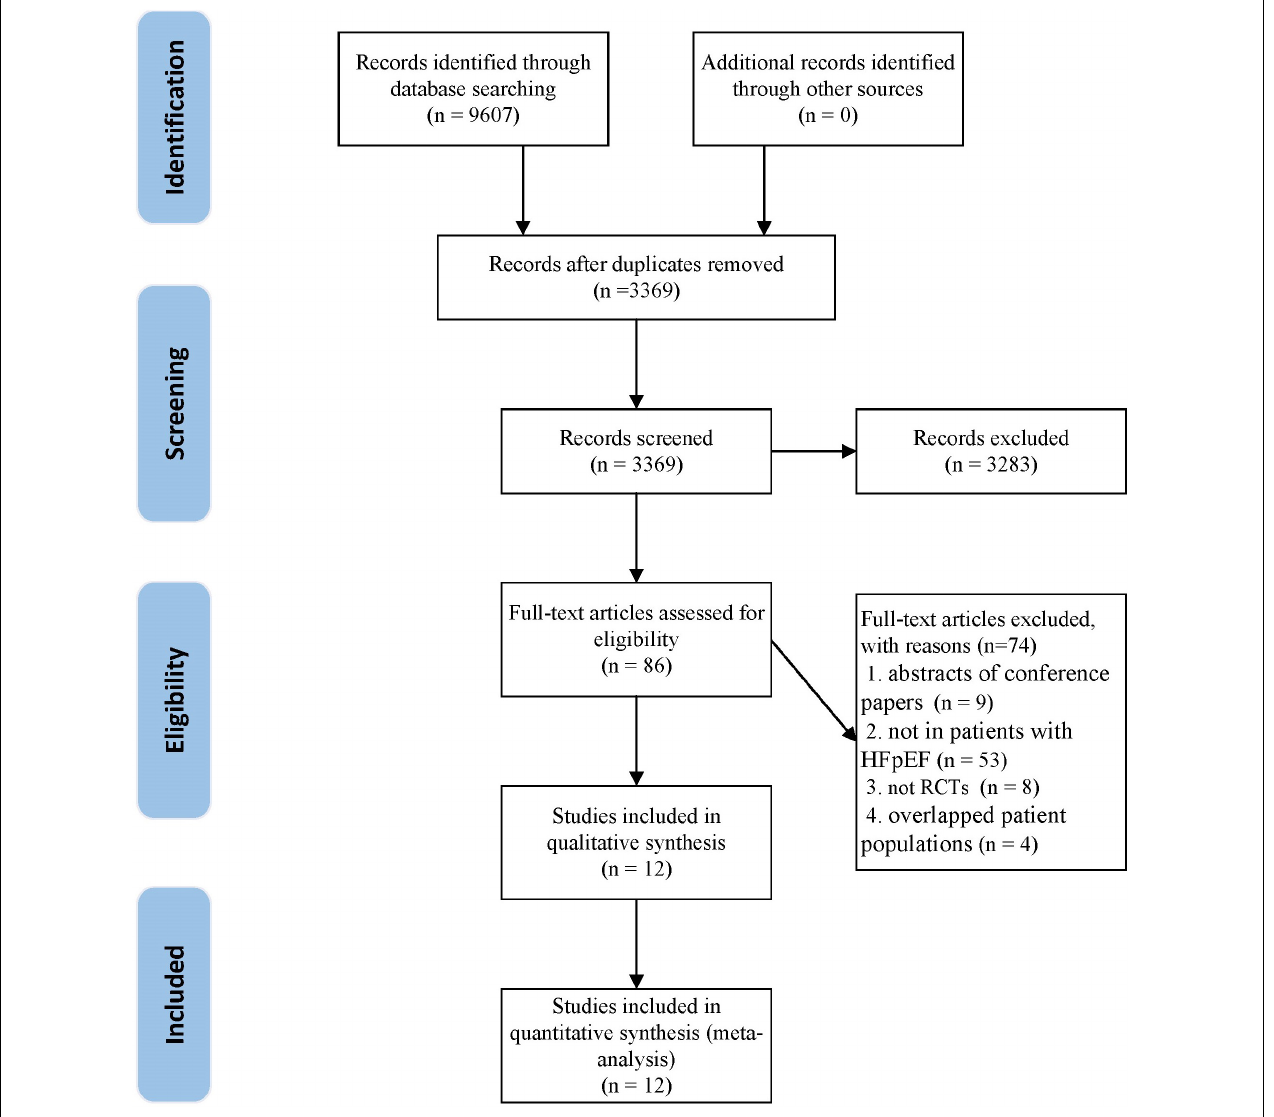
FIGURE 1 | The flow chart of the study selection process showing how to screen eligible randomized controlled